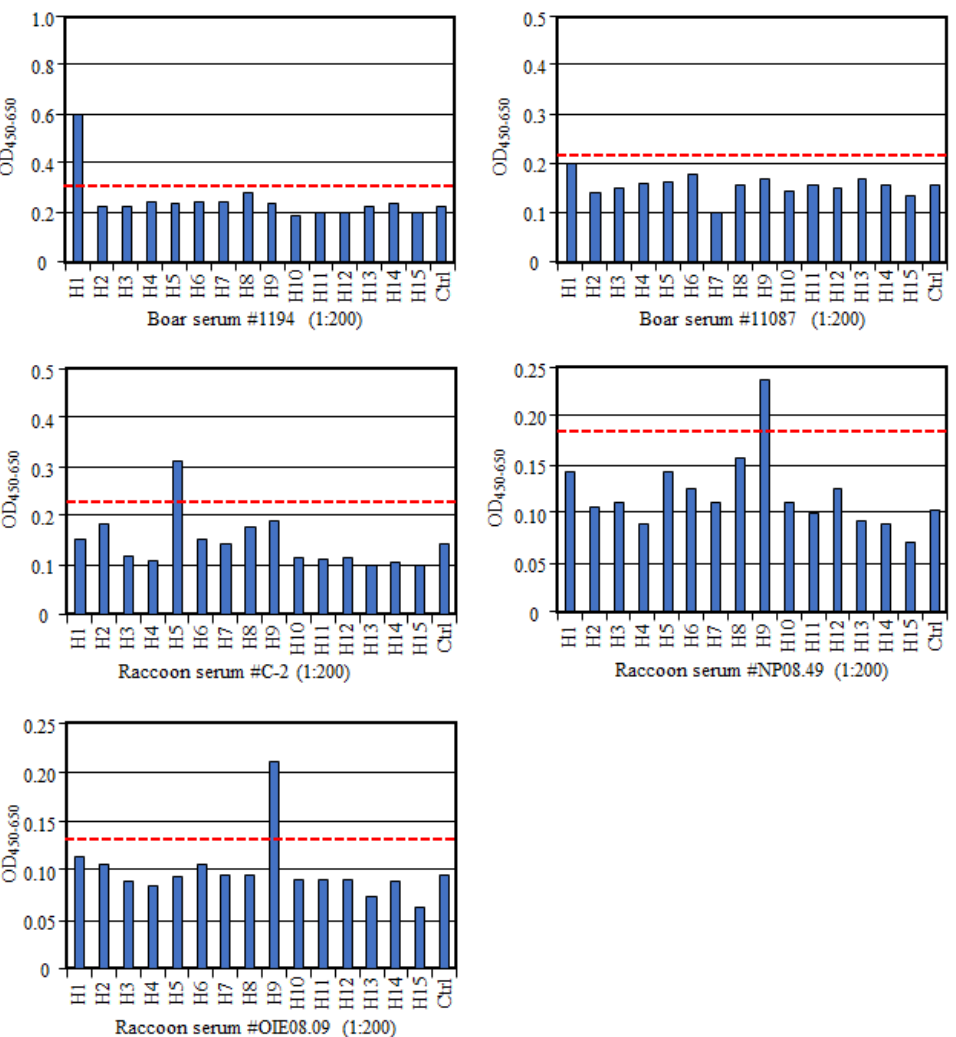
Figure 2. Confirmation of the specificity of the multi-HA-ELISA using wild animal samples. Boar serum #1194 and #11087 were viral neutralizing (VN) positive to H1N1 in the VN test. Raccoon serum #C-251 were VN positive to the H5N1 virus. Raccoon sera #NP08.49 and #OIW08.09 were VN positive to the H9N2 virus. The red dotted line indicates the cut-o ff value. Representative results from multiple experiments are shown in the